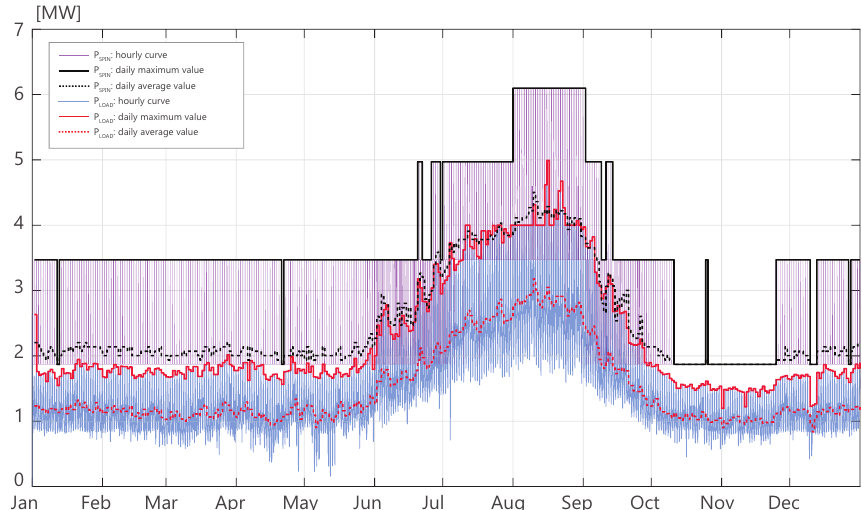
Figure 26. Hourly curve of spinning power P SPIN and load power P LOAD expected by 2030 with the integration of RES and BESS equal to 100% of the objectives of the Decree. Table 24. Forecast of the annual operating data of the generators to 2030 with the integration of BESS and RES to 100% of the objectives of the Decree.